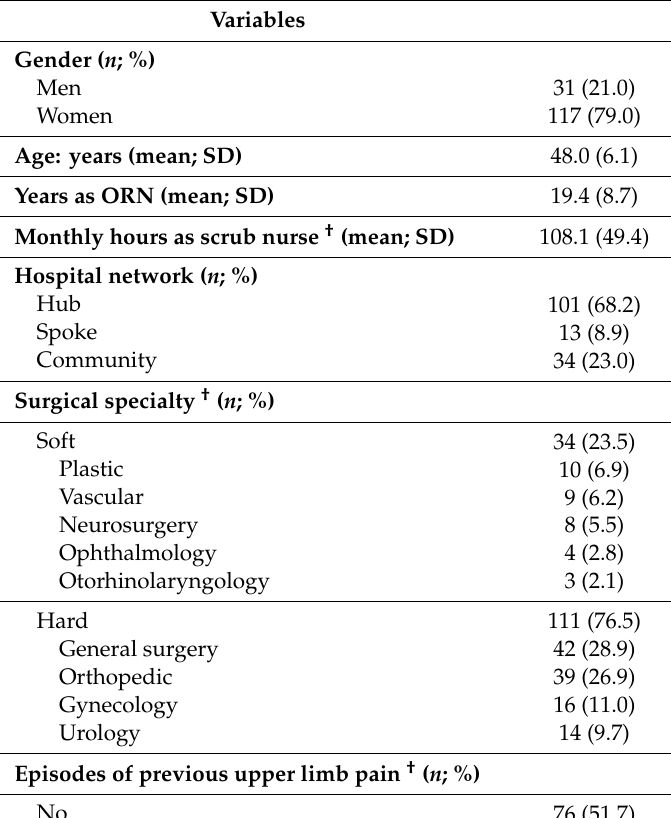
Table 1. Distribution of 148 operating room nurses (ORNs) according to socio-demographics factors, job characteristics, body district pain and disabilities of the arm, shoulder and hand (DASH) score. Italy,